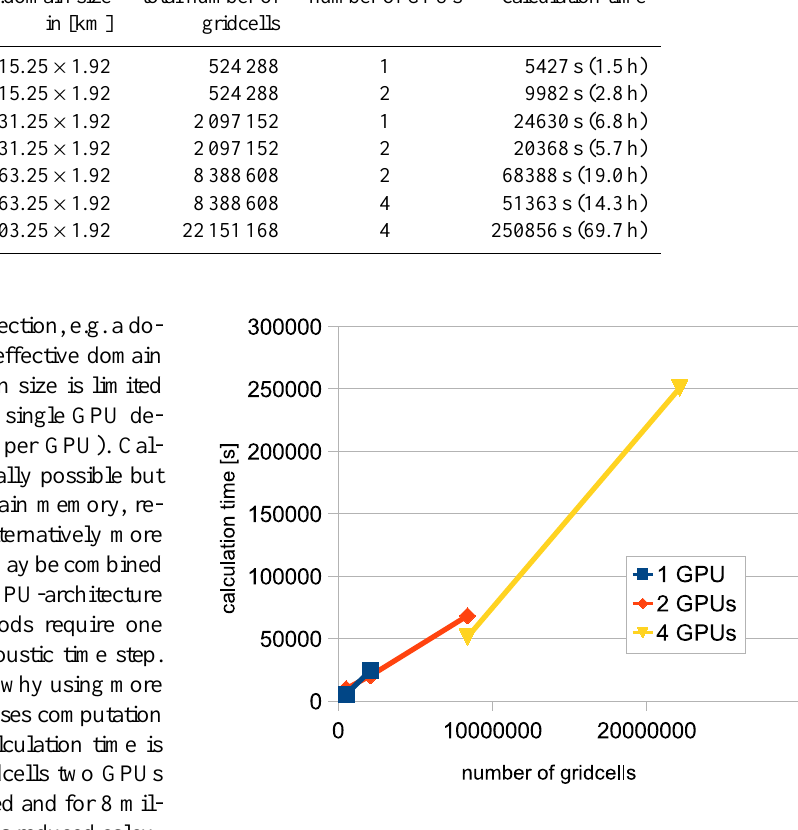
Fig. 7. First performance measurement results (details in Table 1): more GPUs may decrease performance for small domains. For larger domains speedup by using more GPUs increases with domain